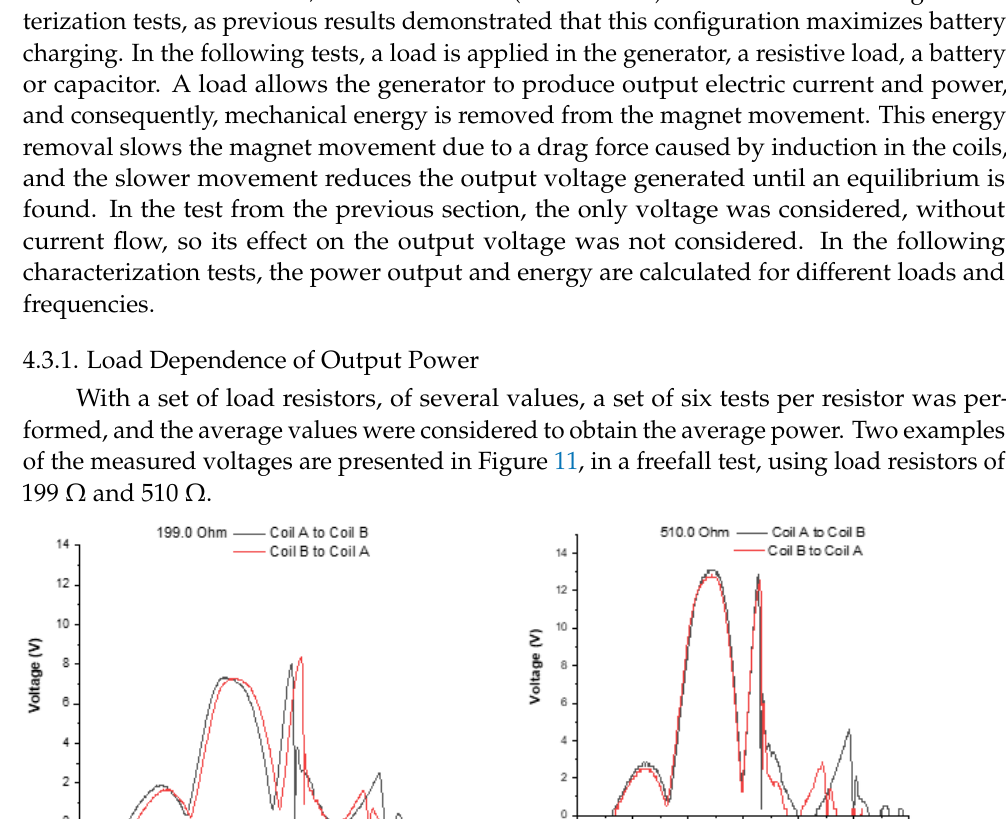
Table 4. Average power vs. load in freefall test.